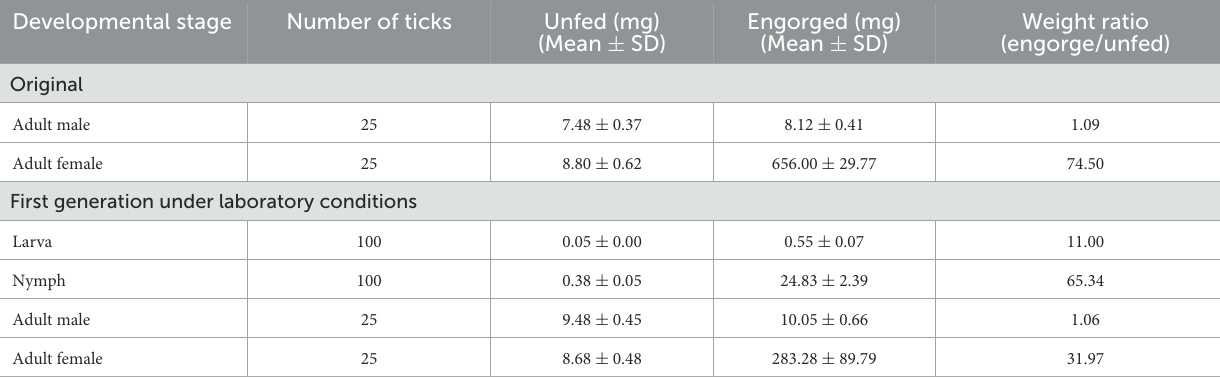
TABLE 4 Changes of body weight of larva, nymph, and adult D. nuttalli before and after feeding. Developmental